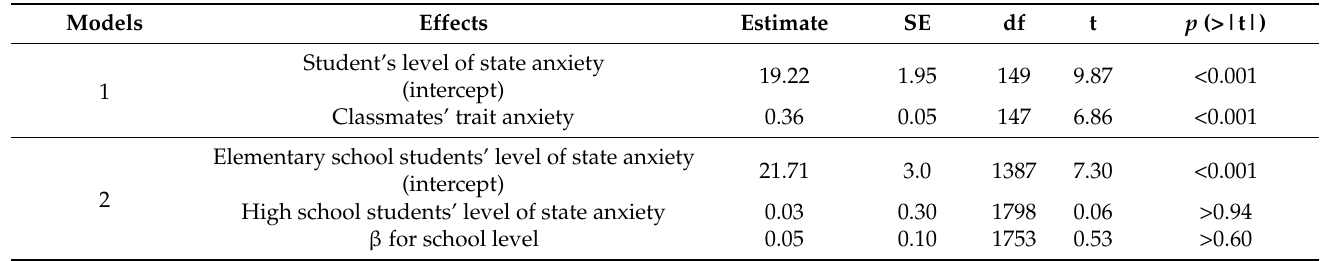
Table 3. Linear mixed-effects models of the association between a student’s level of state anxiety and their classmates’ level of trait anxiety, as well as the effect of the school